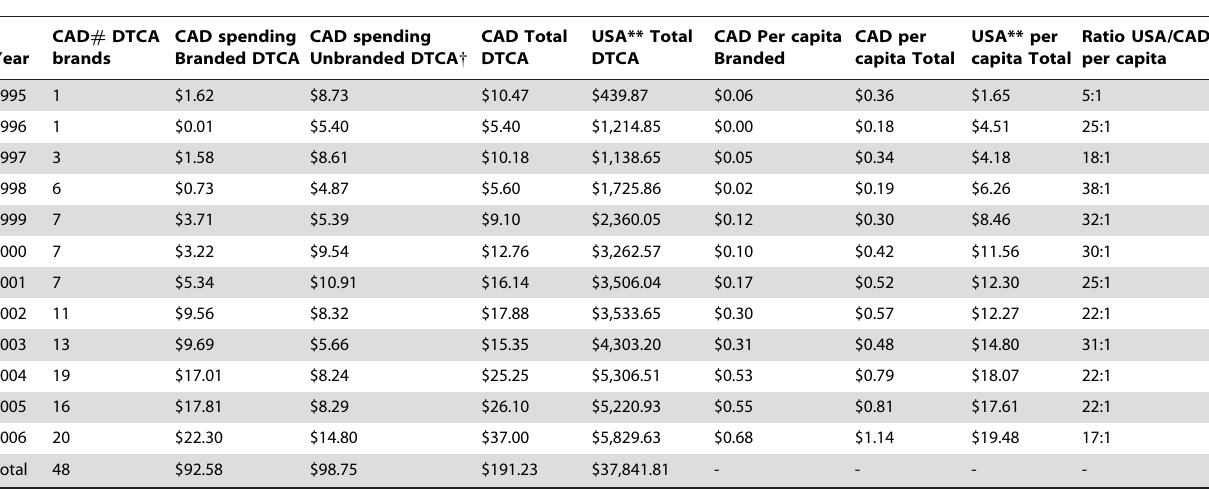
Table 1. Inflation-adjusted spending on DTCA in the U.S. and Canada, all media, 1995 to 2006 (CAD$ millions)*.